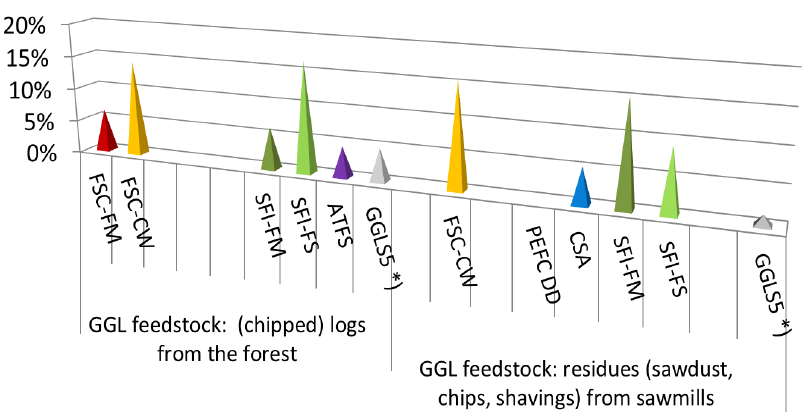
Figure A1. Share of SFM certificates (in % of tonnes wet feedstock **) in the solid biomass certification framework of the Green Gold Label in 2012